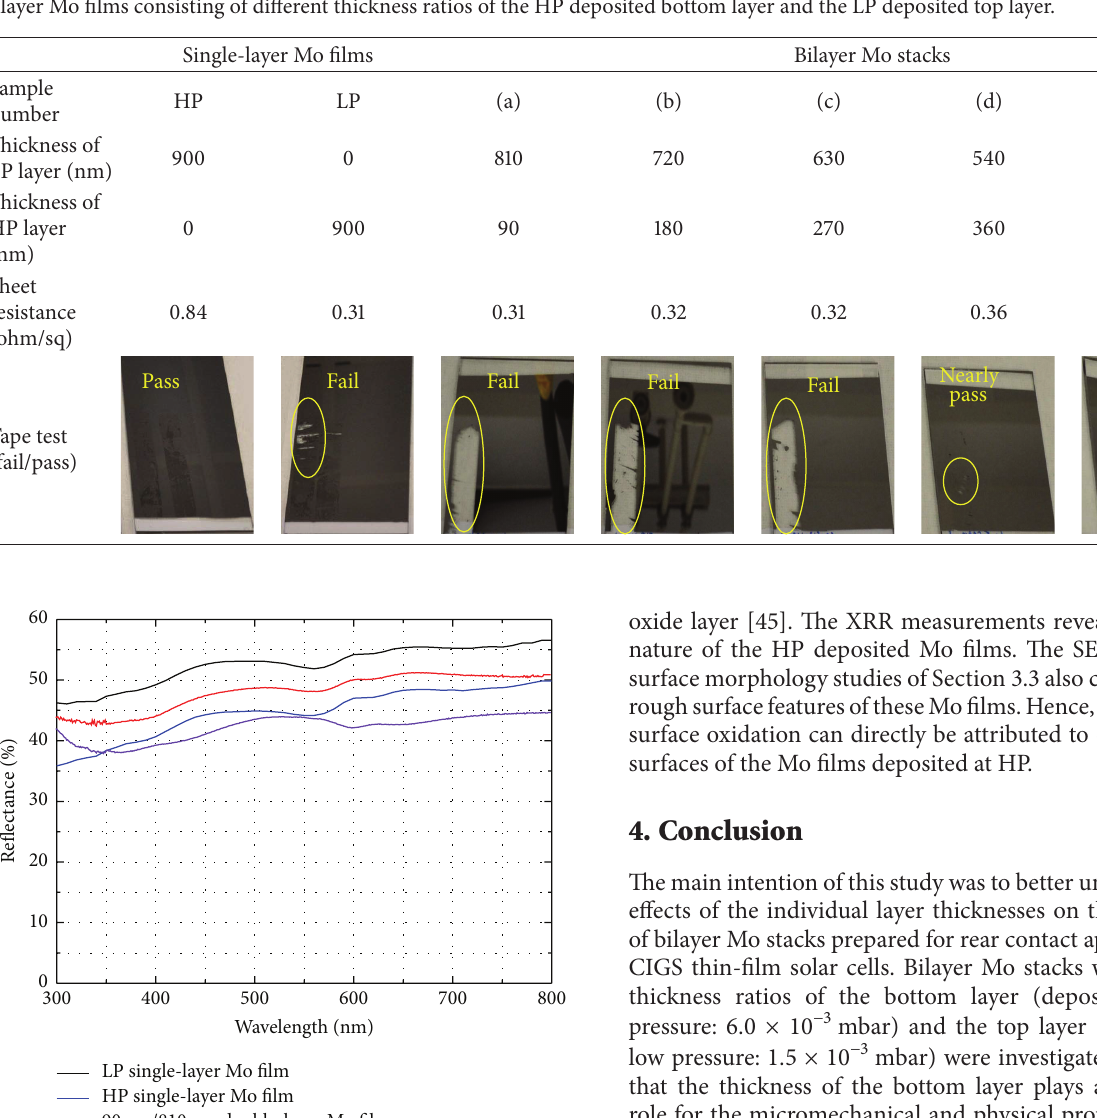
Table 1: Properties of 900nm thick single-layer Mo films deposited at HP (6 × 10 −3 mbar) and LP (1.5 × 10 −3 mbar), as well as 900 nm thick bilayer Mo films consisting of different thickness ratios of the HP deposited bottom layer and the LP deposited top layer.